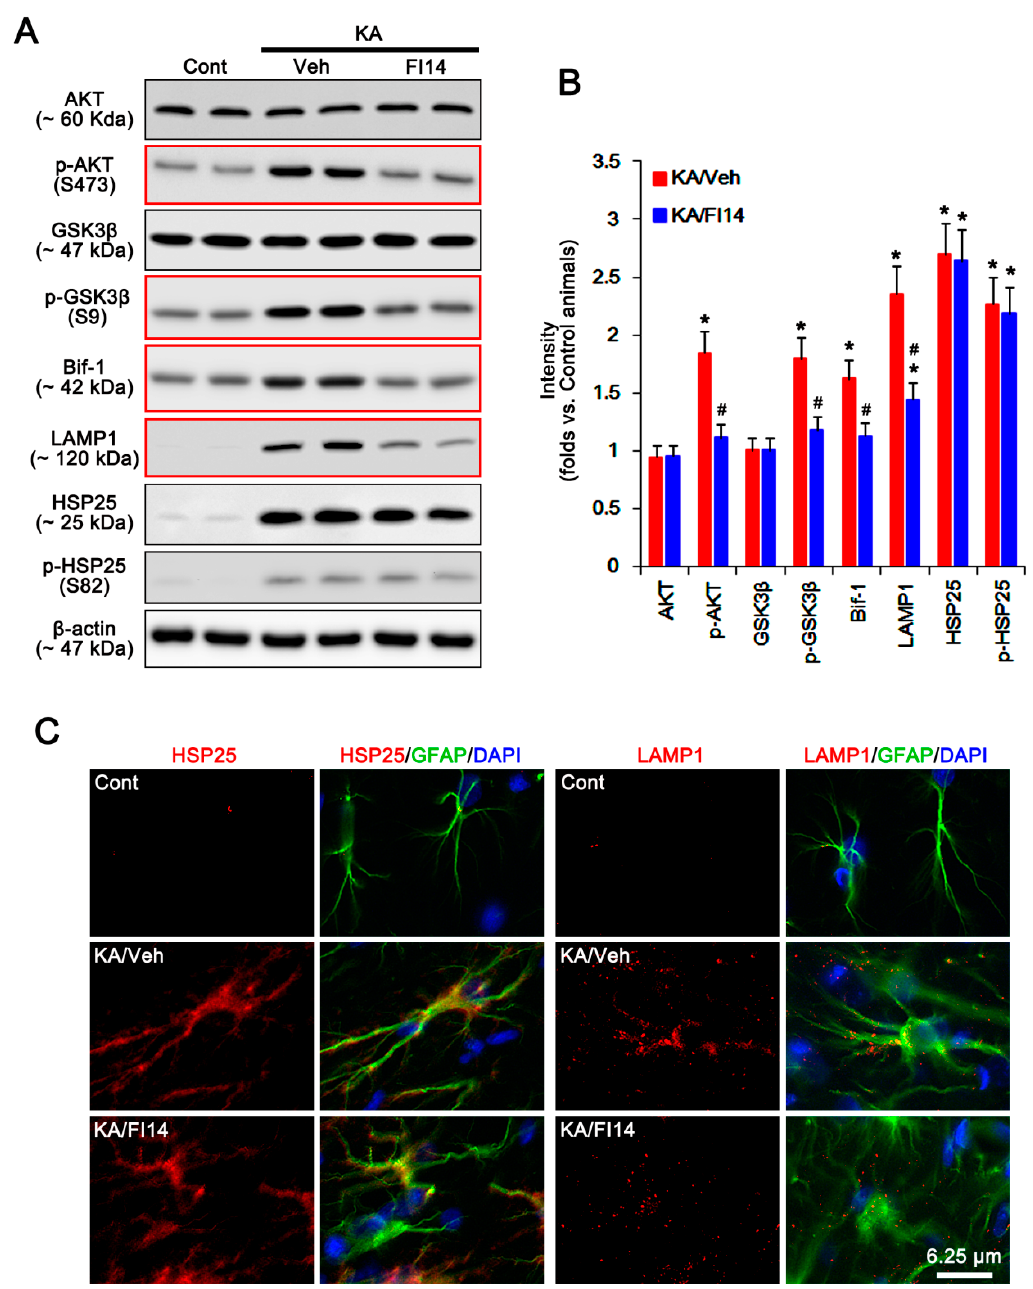
Figure 5. Effects of FAK inhibition on expressions and phosphorylations of AKT, GSK3 β , Bif-1, LAMP1, HSP25, and p-HSP25 in KO astrocytes following KA injection. As compared to vehicle, FAK inhibitor 14 (FI14) abolishes the upregulations of p-AKT-S473, p-GSK3 β -S9, Bif-1, and LAMP1, but not HSP25, levels 7 days after KA injection (red box). ( A ) Representative Western blot of expressions and phosphorylations of AKT, GSK3 β , Bif-1, LAMP1, HSP25, and p-HSP25 in KO astrocytes. Cont, control animals; KA, KA-injected animals; Veh, vehicle; FI4, FAK inhibitor 14. ( B ) Quantifications of expressions and phosphorylations of AKT, GSK3 β , Bif-1, LAMP1, HSP25, and p-HSP25 in KO astrocytes following KA injection (mean ± SEM; * ,# p < 0.05 vs. control KO astrocytes and vehicle, respectively; n = 7, respectively). ( C ) Effect of P2X7R deletion on HSP25 and LAMP1 expression in the hippocampal astrocytes. As compared to vehicle, FI14 abrogates LAMP1, but not HSP25, expression in KO mice 7 days after KA injection.